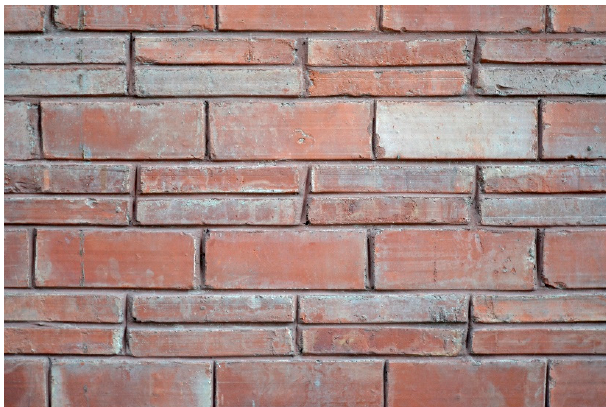
Figure 18. Special Lakhori bricks used for cladding the IHC building (Photo: Author).